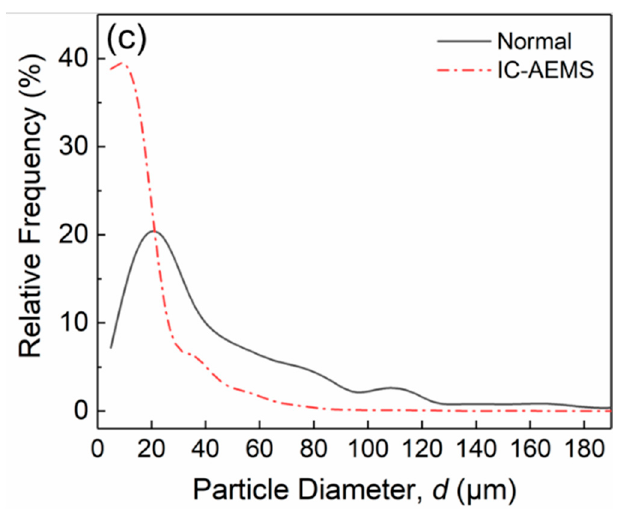
Figure 7. SEM micrographs of the primary Al 3 Zr particles in the deeply-etched samples: ( a ) without treatment; ( b ) with IC-AEMS. ( c ) The size distribution of Al 3 Zr particles in the Al-Zn-Mg-Cu-Zr alloy.